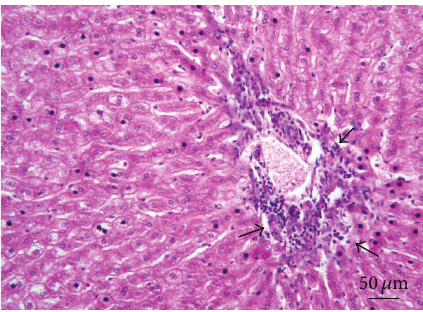
Figure 8: Liver. Lesion Grade I. Mild nonsuppurative periportal interstitial infiltration (arrow) and initial hepatocytes degenerative changes. Hematoxylin and eosin.